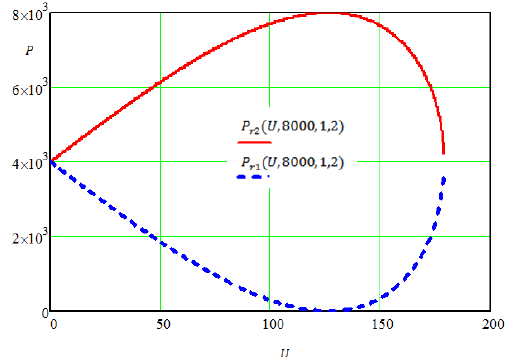
Figure 11. The initial set of the solutions of Equation (14).